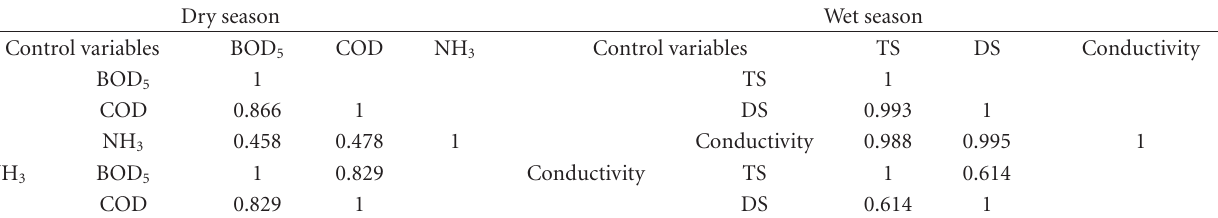
Table 4: Partial correlations of the dry and wet season